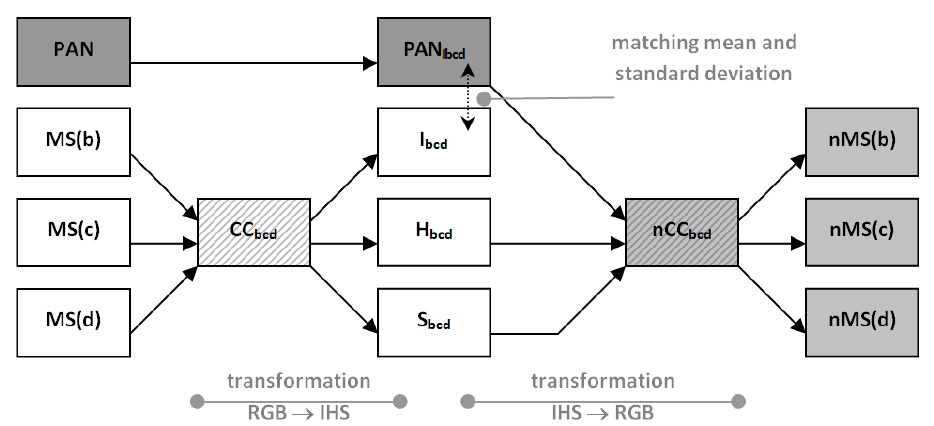
Figure 5. Diagram of the spatial enhancement procedure using the intensity hue saturation (his) method.